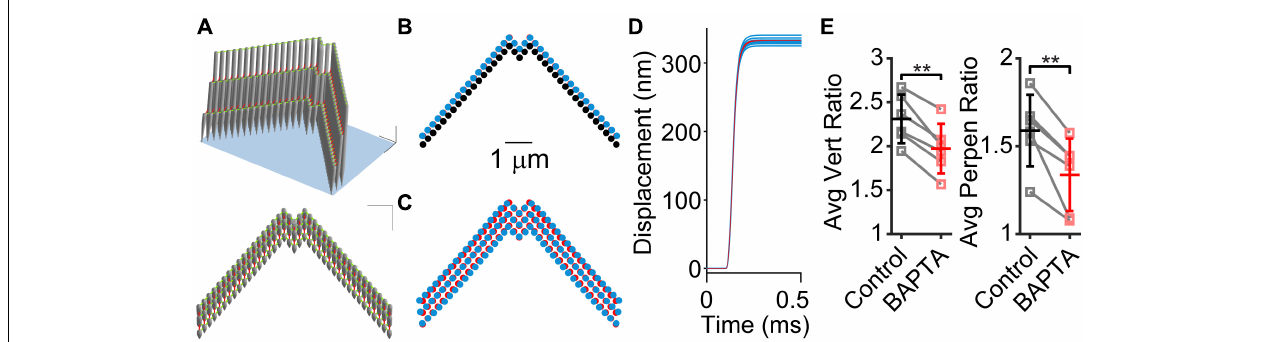
FIGURE 4 | Stereocilia displacement non-uniformity is greater when lateral links are present. (A) 3D model of stereocilia hair bundle is shown in two perspectives with tip-links shown in red and lateral links in green. (B) Movement of the tallest row of stereocilia from the rest position (black) to the final position when tip links are present with (blue) and without (red) lateral links. Note that the blue almost entirely covers the red stereocilia. (C) Position of stereocilia in the entire bundle that is multiplied by five times to visualize the difference between the presence (blue) and absence (red) of lateral links. (D) Plots of the displacement of individual stereocilia showing that when lateral links are present (blue traces) there is a distribution of displacement sizes, whereas when lateral links are absent, displacement sizes are the same for each stereocilium (red traces). (E) Re-analyzing experiments in Caprara et al. (2020) with BAPTA treatment of hair bundles show that after BAPTA treatment, hair bundle non-uniformity is decreased. The center (C) normalized vertical ratios on the left (L) and right (R) side of the hair bundle were averaged for stimulations before (control) and after BAPTA treatment in the same cells. For controls, the largest stimulation was used and after BAPTA treatment, we used the closest matched center displacement stimulation for the calculation. We preformed this analysis using both vertical motion and perpendicular motion like Figures 1A,B ( n = 6, Vert, p = 0.0011; Perpen, p = 0.0050). ** p < 0.01.